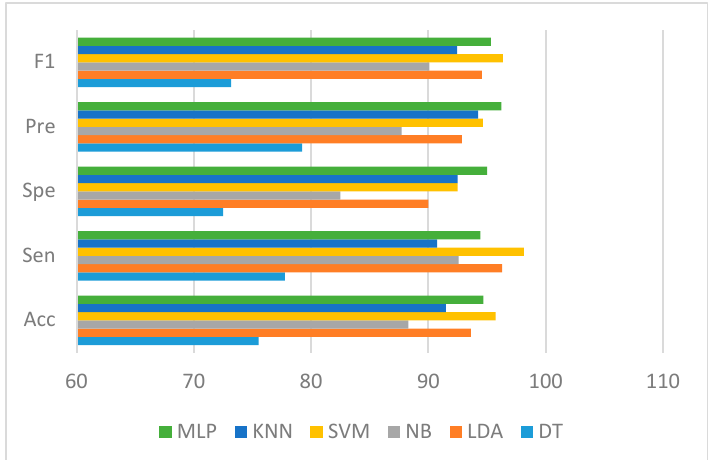
Figure 13. Performance comparison of the classifiers in terms of metrics derived from the confu- sion